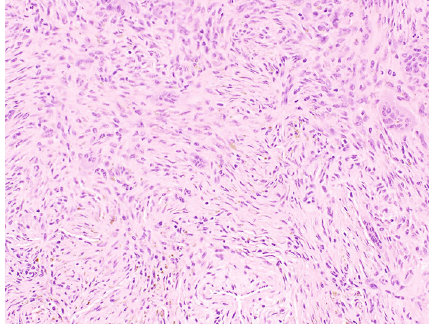
Figure 5: Pathology of nonossifying fi broma (magni fi cation × 200). The lesion shows spindle cells in a storiform pattern with admixed multinucleated giant cells and hemosiderin-laden